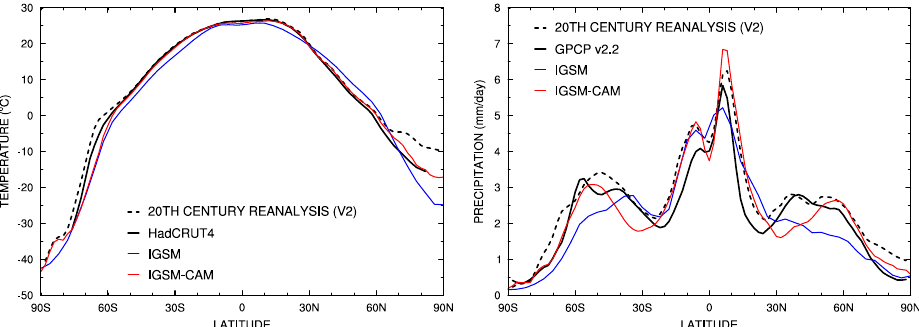
Fig. 6. Latitudinal distribution of present-day (1981–2010 period) zonal-mean (left) surface air temperature ( ◦ C) and (right) precipitation (mmday − 1 ) for the IGSM and IGSM-CAM simulations, under median climate sensitivity, and for two sets of observational data: HadCRUT4 and 20CR V2 for temperature, and GPCP v2.2 and 20CR V2 for